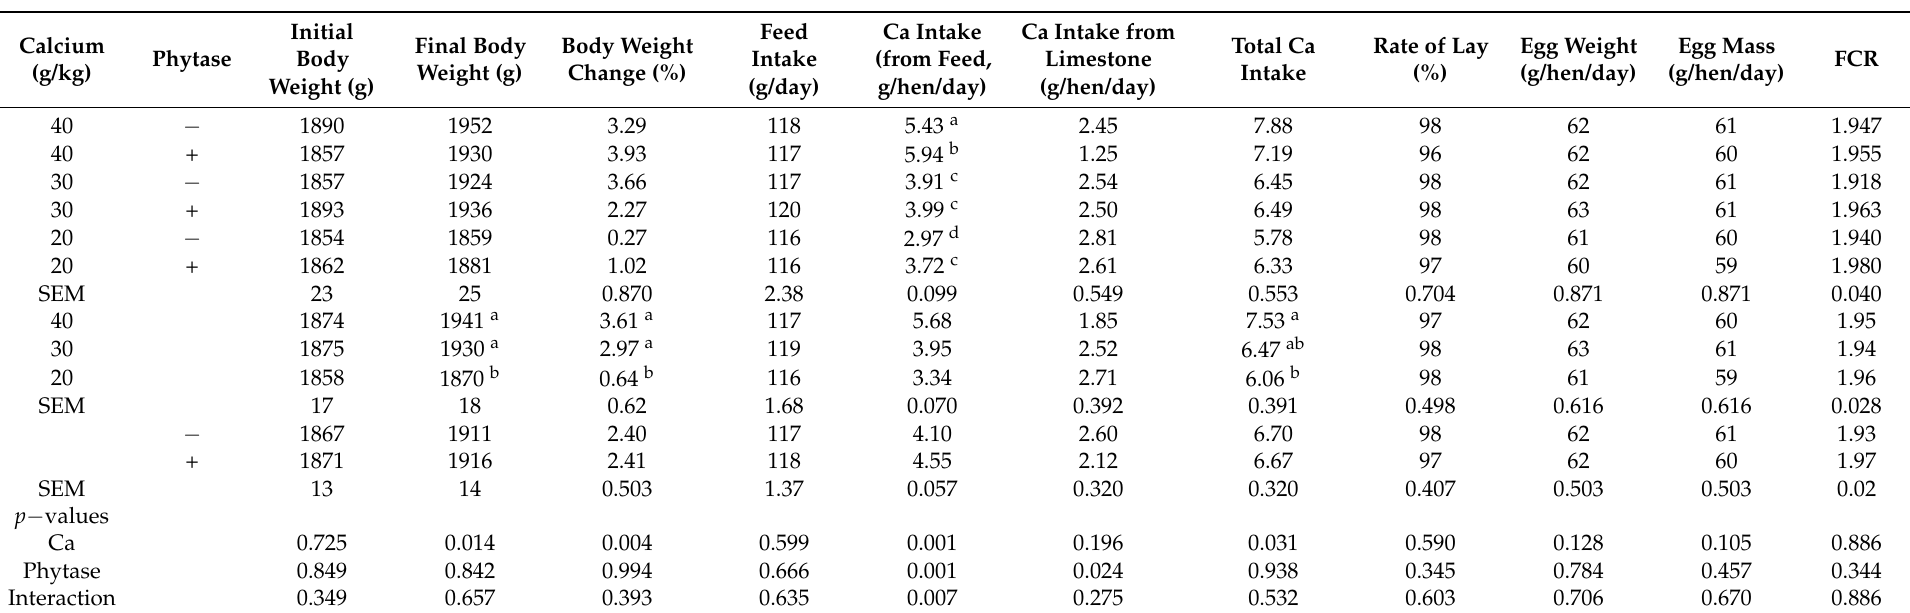
Table 3. Effect of differing calcium levels and addition of phytase on bodyweight and feed intake of laying hens (19–24 weeks of